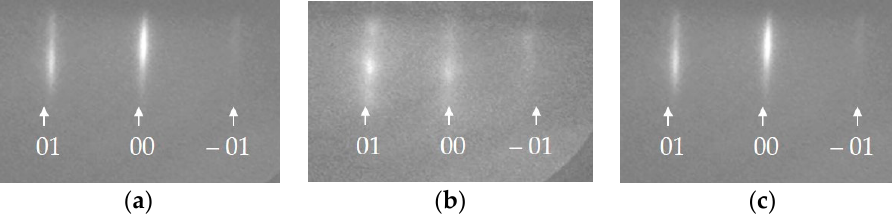
Figure 2. Evolution of RHEED patterns illustrating 2D and 3D growth modes at different (Al + Ga)/NH 3 flux ratios: ( a ) 2D-grown barrier at 20 sccm of ammonia; ( b ) 3D-grown well at 5.5 sccm of